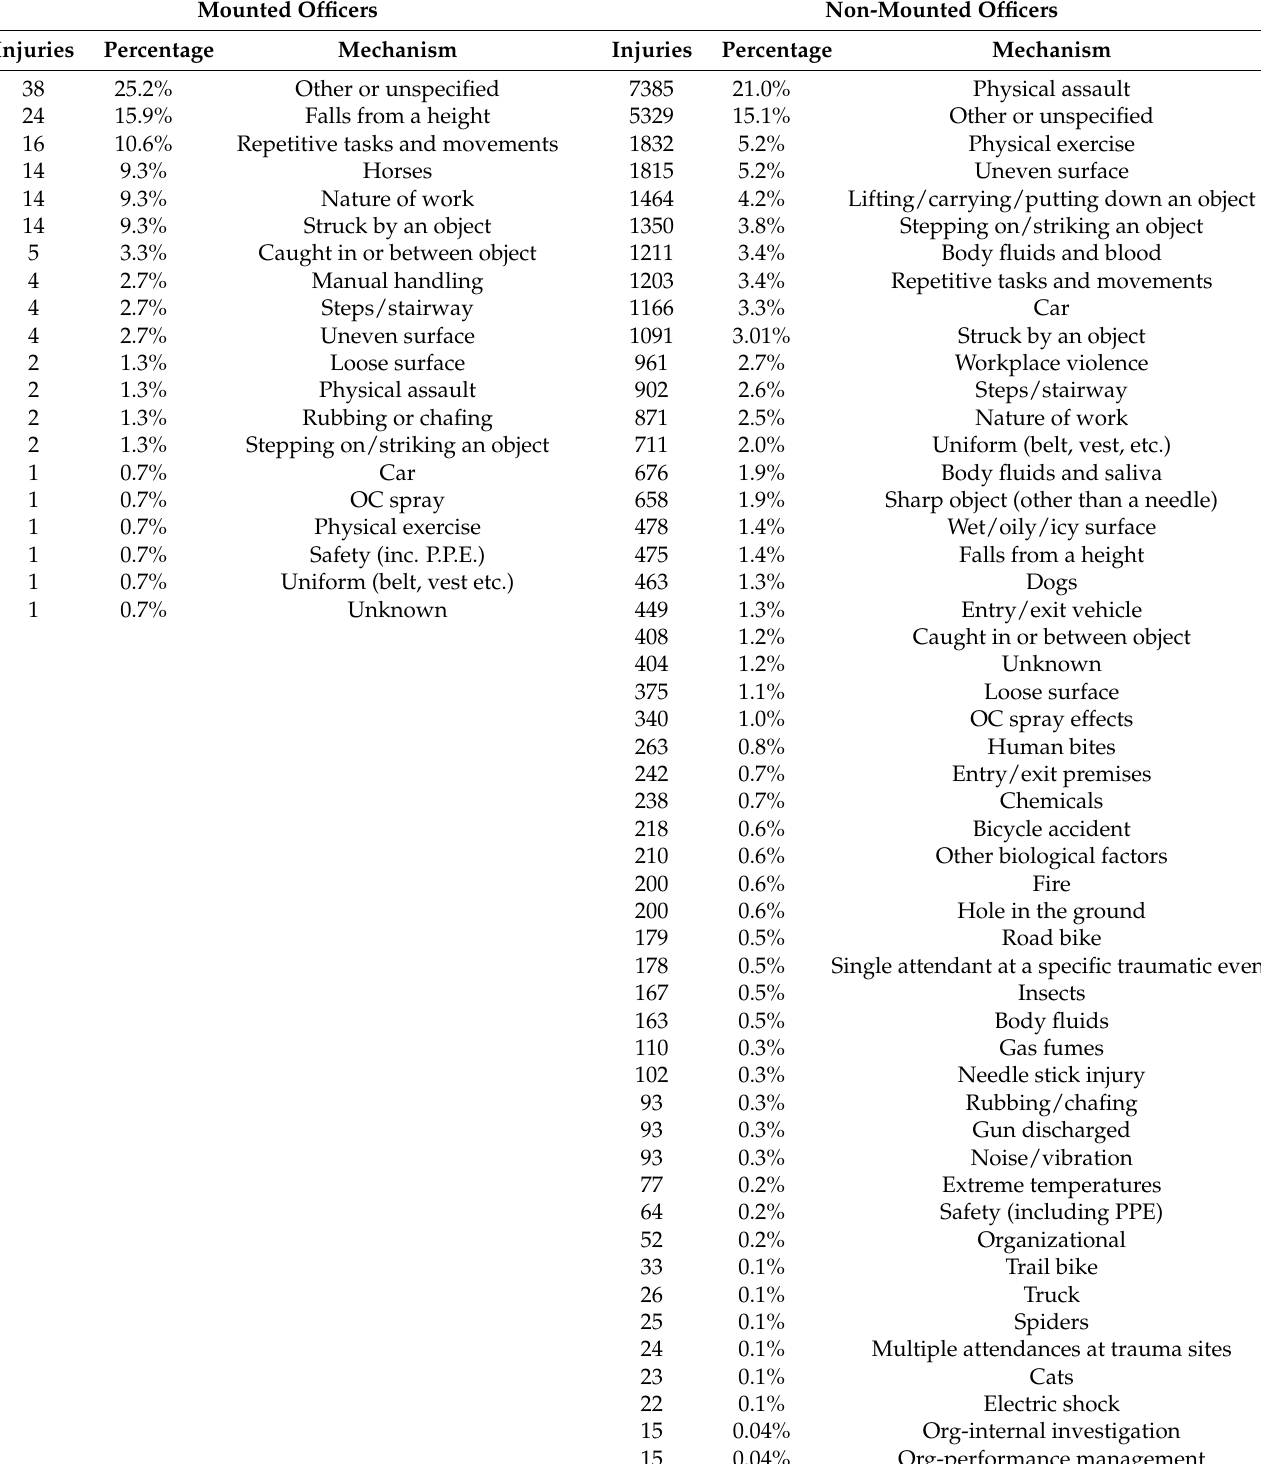
Table 4. Injuries by reported